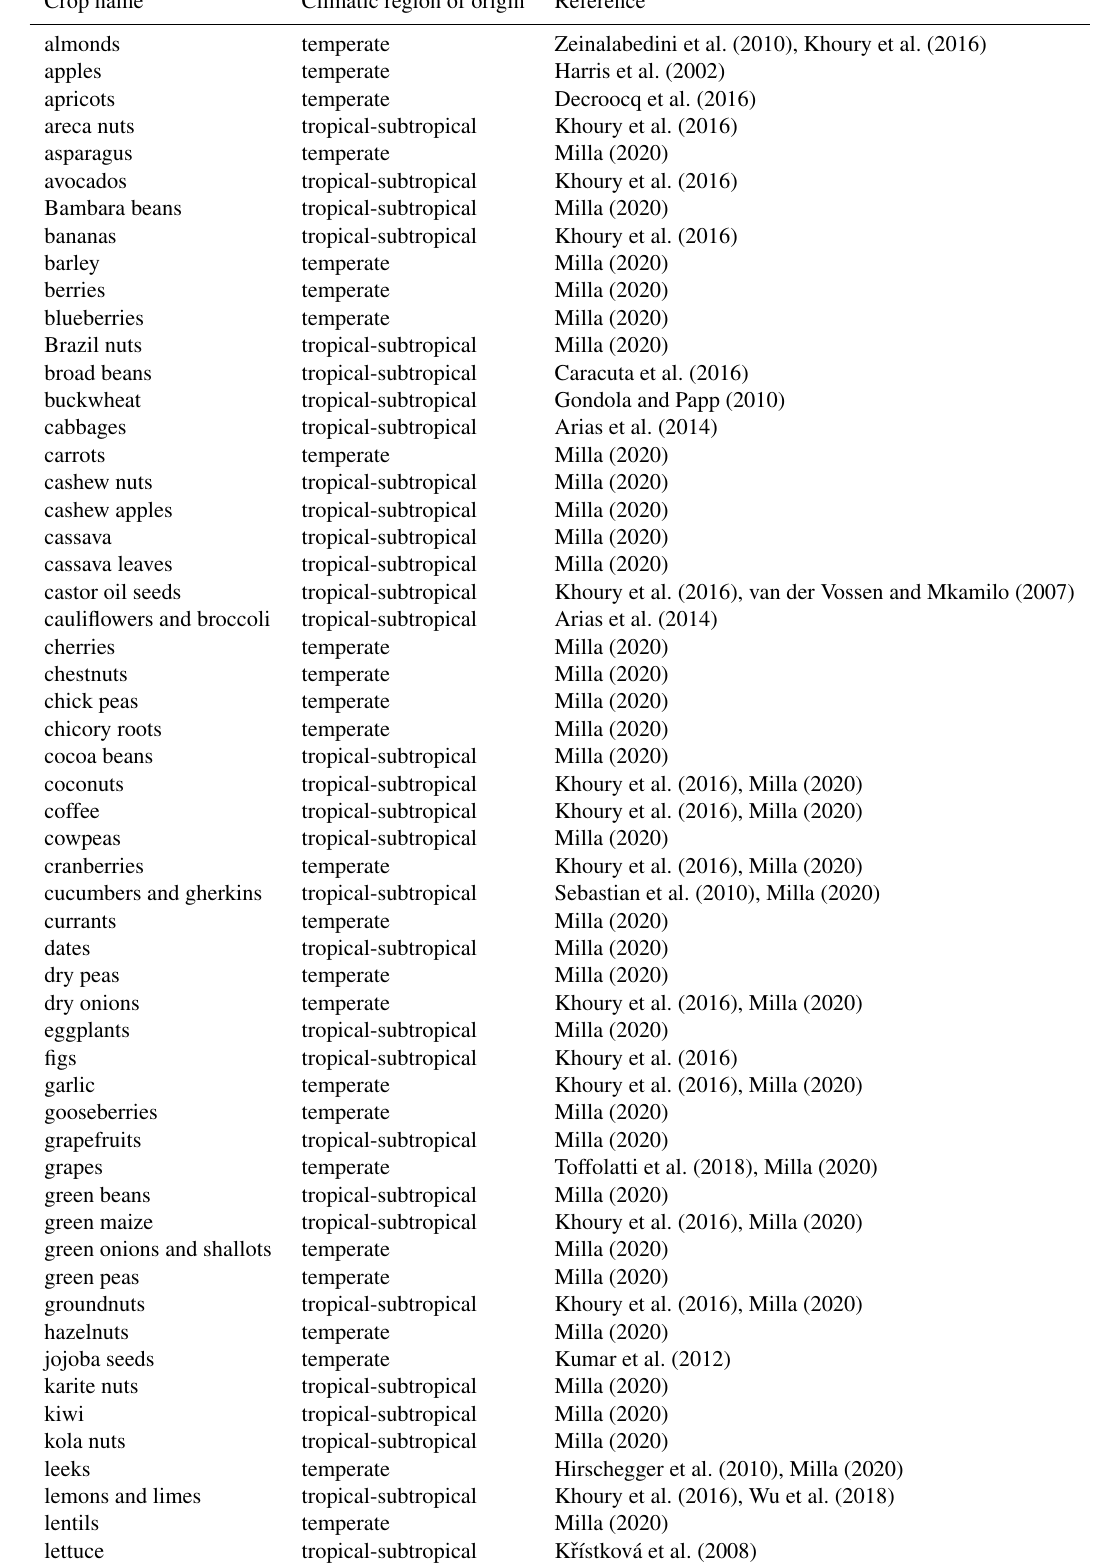
Table A2. Bibliographical sources for the climatic region of origin of the crops included in the